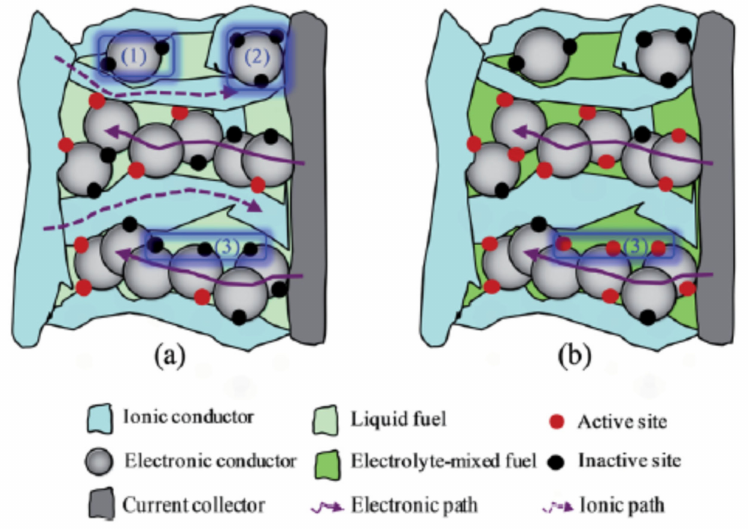
Figure 3. Schematic illustration of the catalyst layer and the regions (in red color) of ( a ) triple-phase boundary, and ( b ) two-phase boundary. Reprinted with permission from Ref [53]. Copyright 2014 Royal Society of